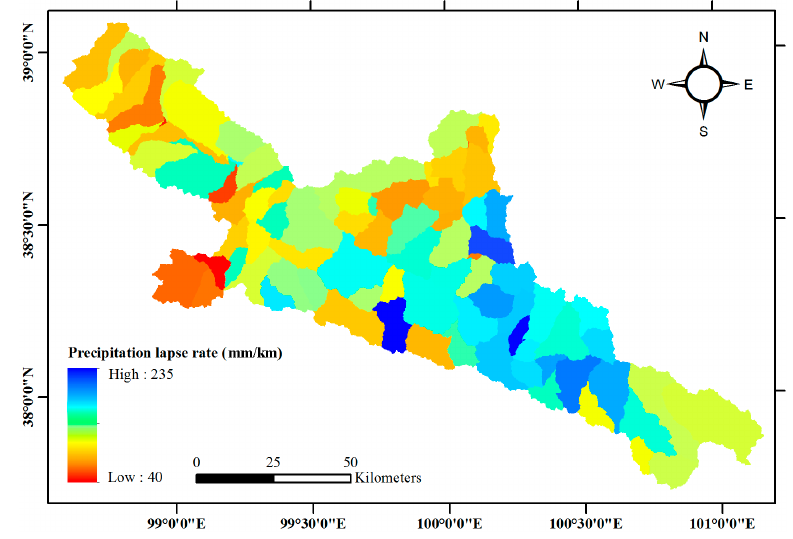
Figure 8. Distribution of the sub-basin precipitation lapse rate.